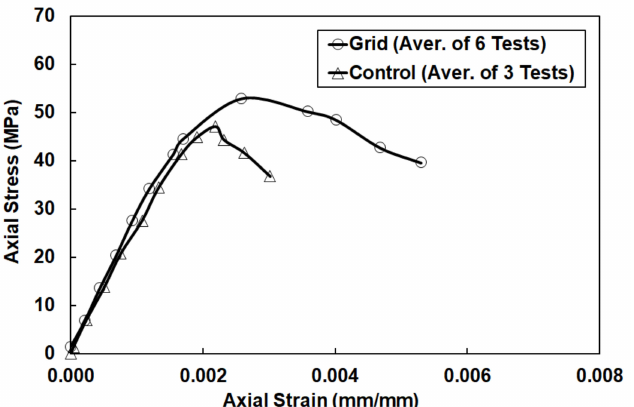
Figure 7. Average experimental stress–strain curves for control and grid